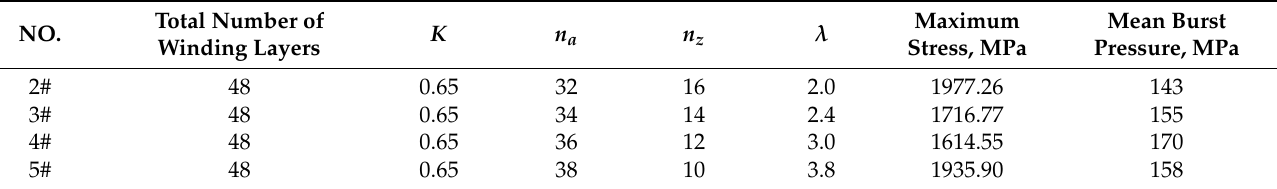
Table 3. Design parameters and test results of COPVs